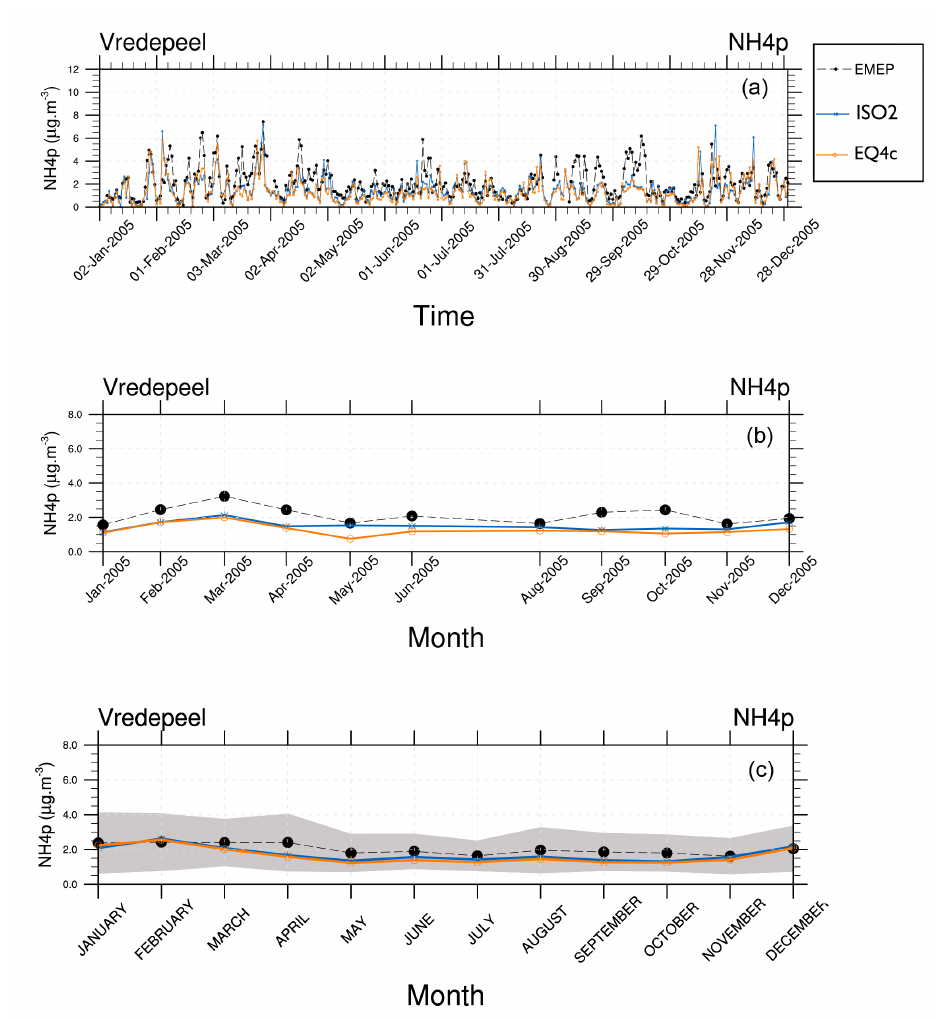
Figure 11. Total (liquids and solids) particulate ammonium (NH + means (b) , climatological year based on the 14-year monthly mean (c) . ISORROPIA II (ISO2) and EQSAM4clim (EQ4c) versus observations